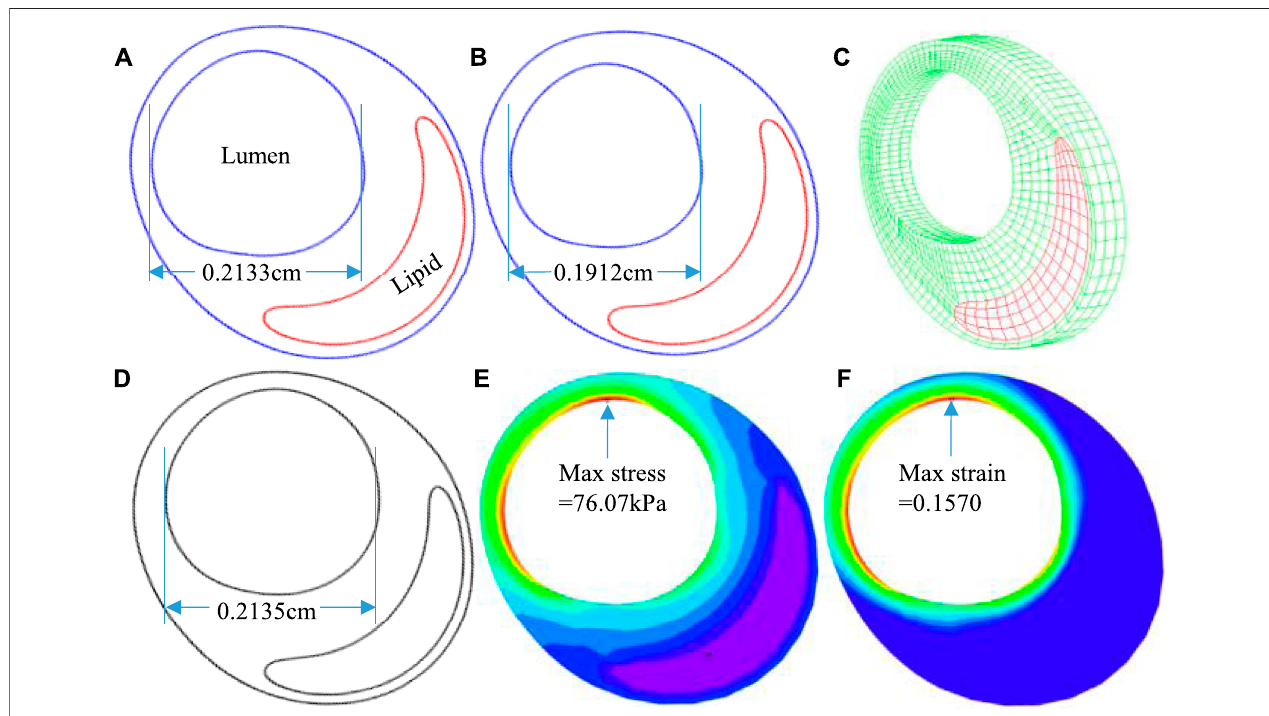
FIGURE 3 | The 3D thin-layer model construction process. (A) An in vivo IVUS + OCT (IO) slice. (B) The slice after shrinking. (C) The 3D thin-layer model with a thicknessadded. (D) Theslicewithload-addedmatching invivo slicemorphology. (E) Plaquewallstressunderminimumpressure. (F) Plaquewallstrainunderminimum